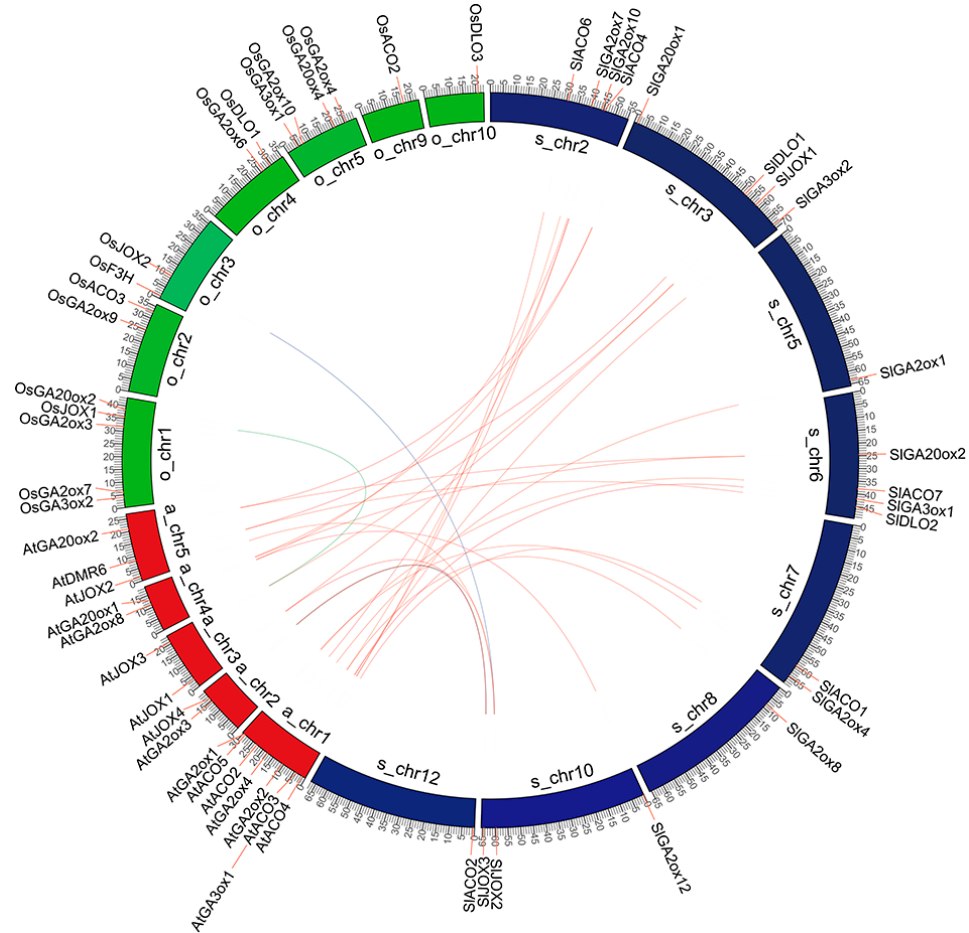
Figure 2. Synteny analysis of hormone biosynthetic and metabolism 2-oxoglutarate-dependent dioxygenase (2OGD) genes among Arabidopsis , rice, and tomato. Chromosome numbers of Arabidopsis (At), rice (Os), and tomato (Sl) are indicated on the inner side. Red, green, and blue colors represent Arabidopsis , rice, and tomato chromosomes. Gene pairs with a collinear relationship are joined by lines. Red lines represent collinear pairs between Arabidopsis and tomato, blue lines represent collinear pairs between Arabidopsis and rice, green lines represent collinear pairs between rice and tomato.